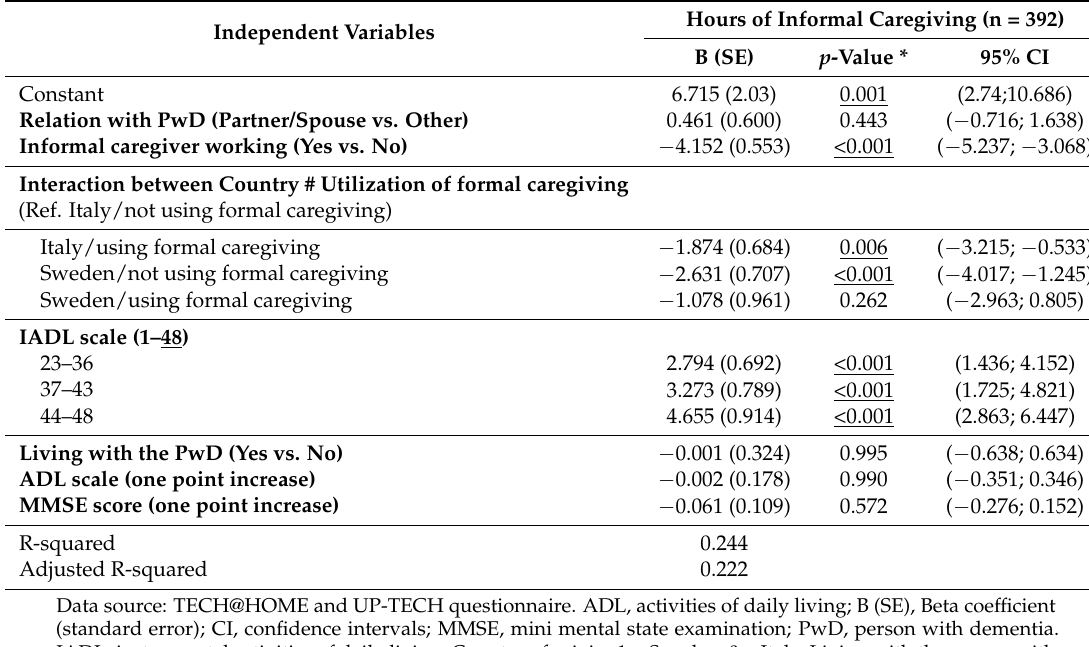
Table 4. Factors associated with hours of informal